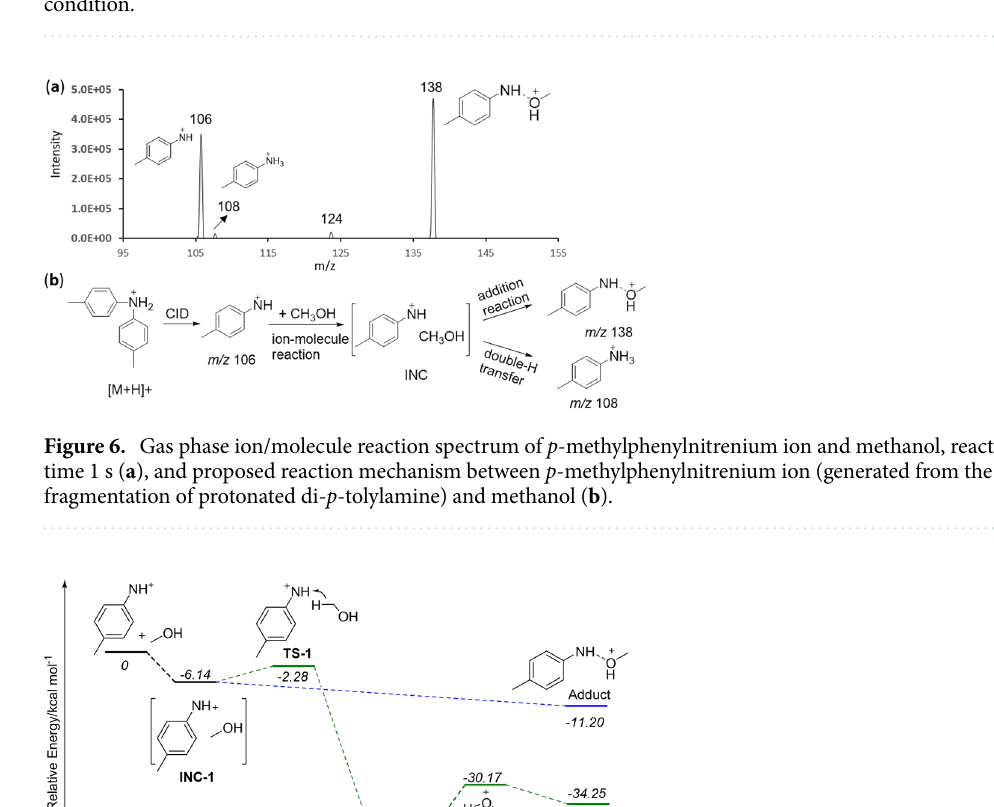
Figure 5. Proposed mechanism of the formation of protonated p -toluidine from toluene under the APCI condition.